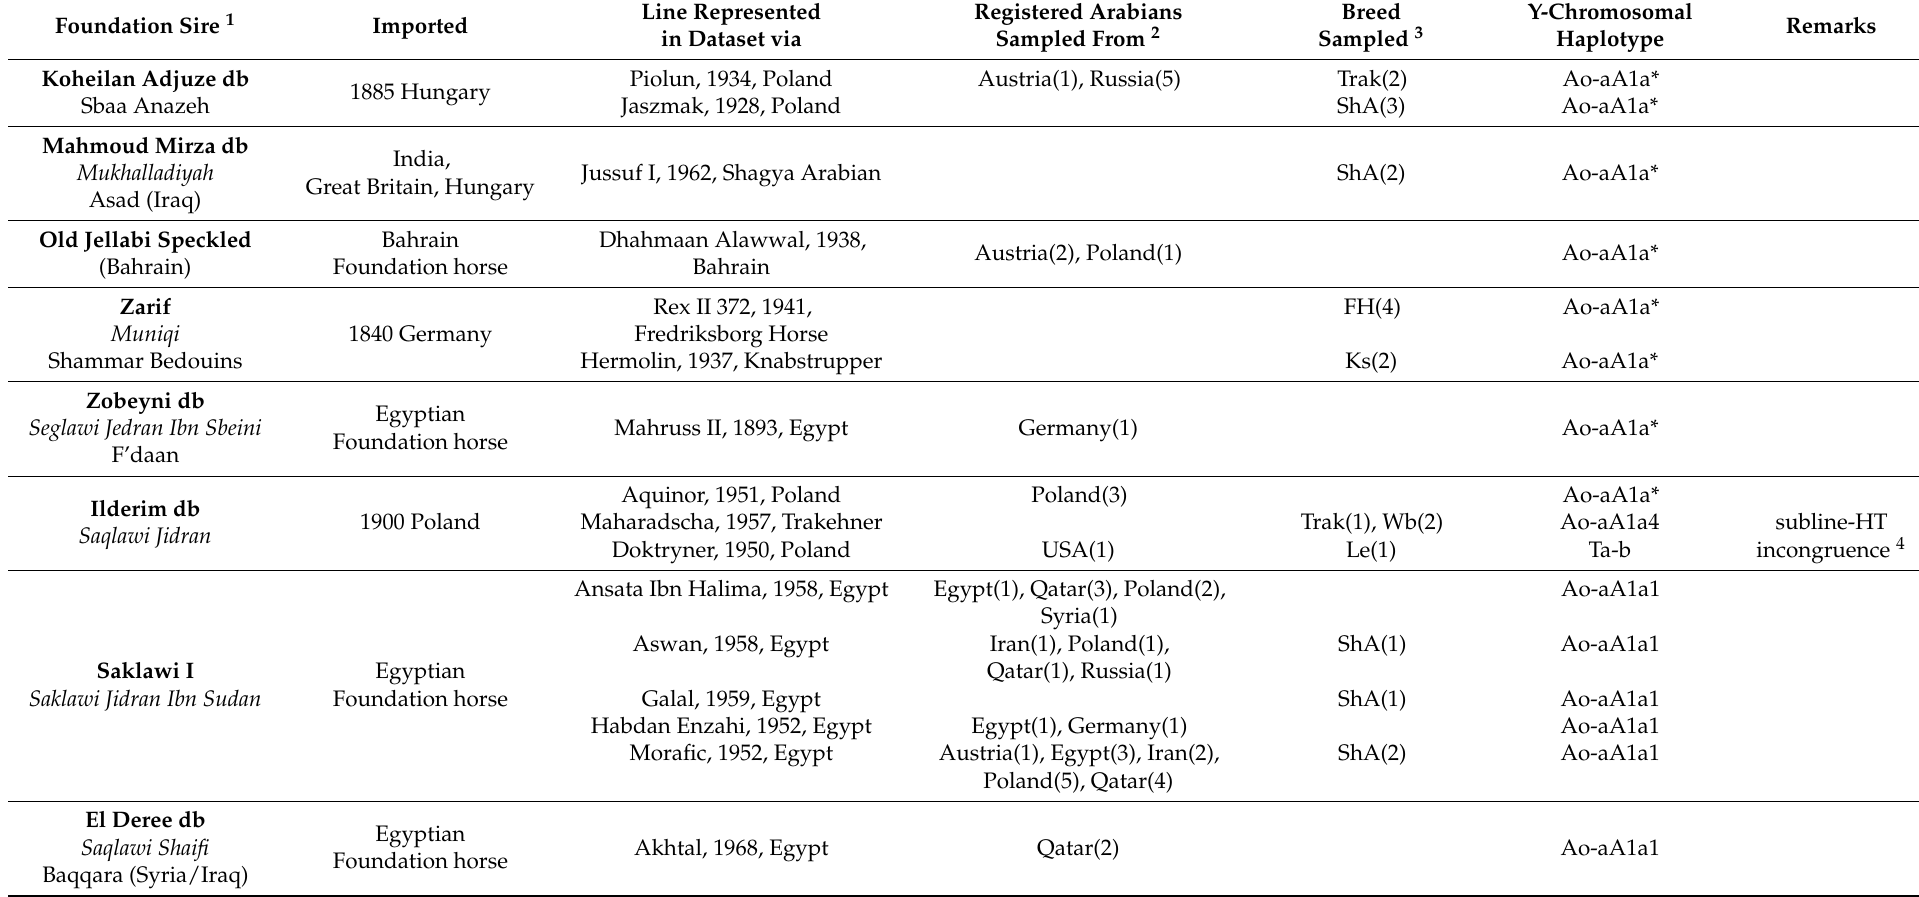
Table 1. Y chromosome haplotypes in occidental Arabian horse lines. Full information about the 145 males sampled (81 registered Arabians and 67 from other breeds), including the tail-male line, is given in Table S5. See Figure 2 for genetic relationships among the